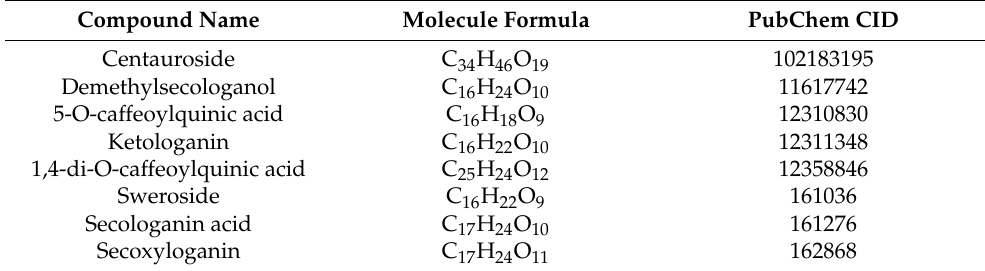
Table 1. Active compounds of Lonicera japonica Thunberg (LJ). The 26 compounds and their PubChem compound identification numbers (CIDs) based on the Oriental Advanced Searching Integrated System (OASIS)